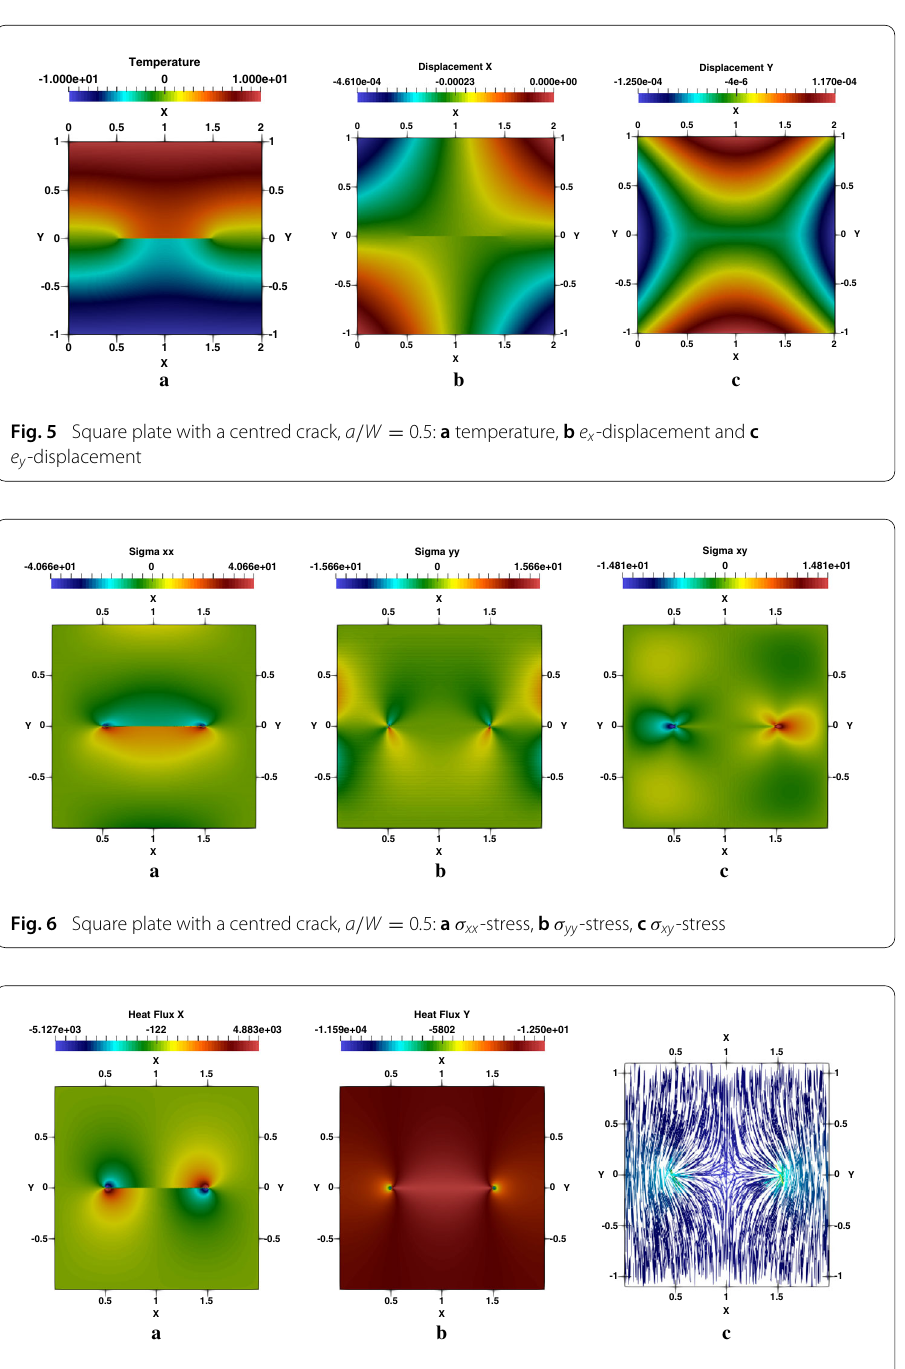
Fig. 7 Square plate with a centred crack, a / W = 0 . 5: a q x -heat flux, b q y -heat flux, c flux lines